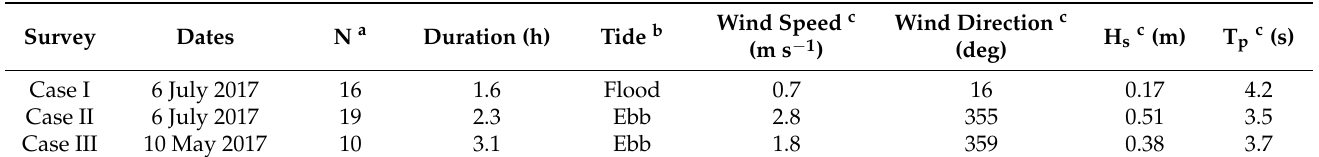
Table 1. Drifter hydrodynamic survey details (a, number of drifters used; b, measured by Zhuwei tide gauge; c, wind and wave conditions at Hsinchu data buoy.